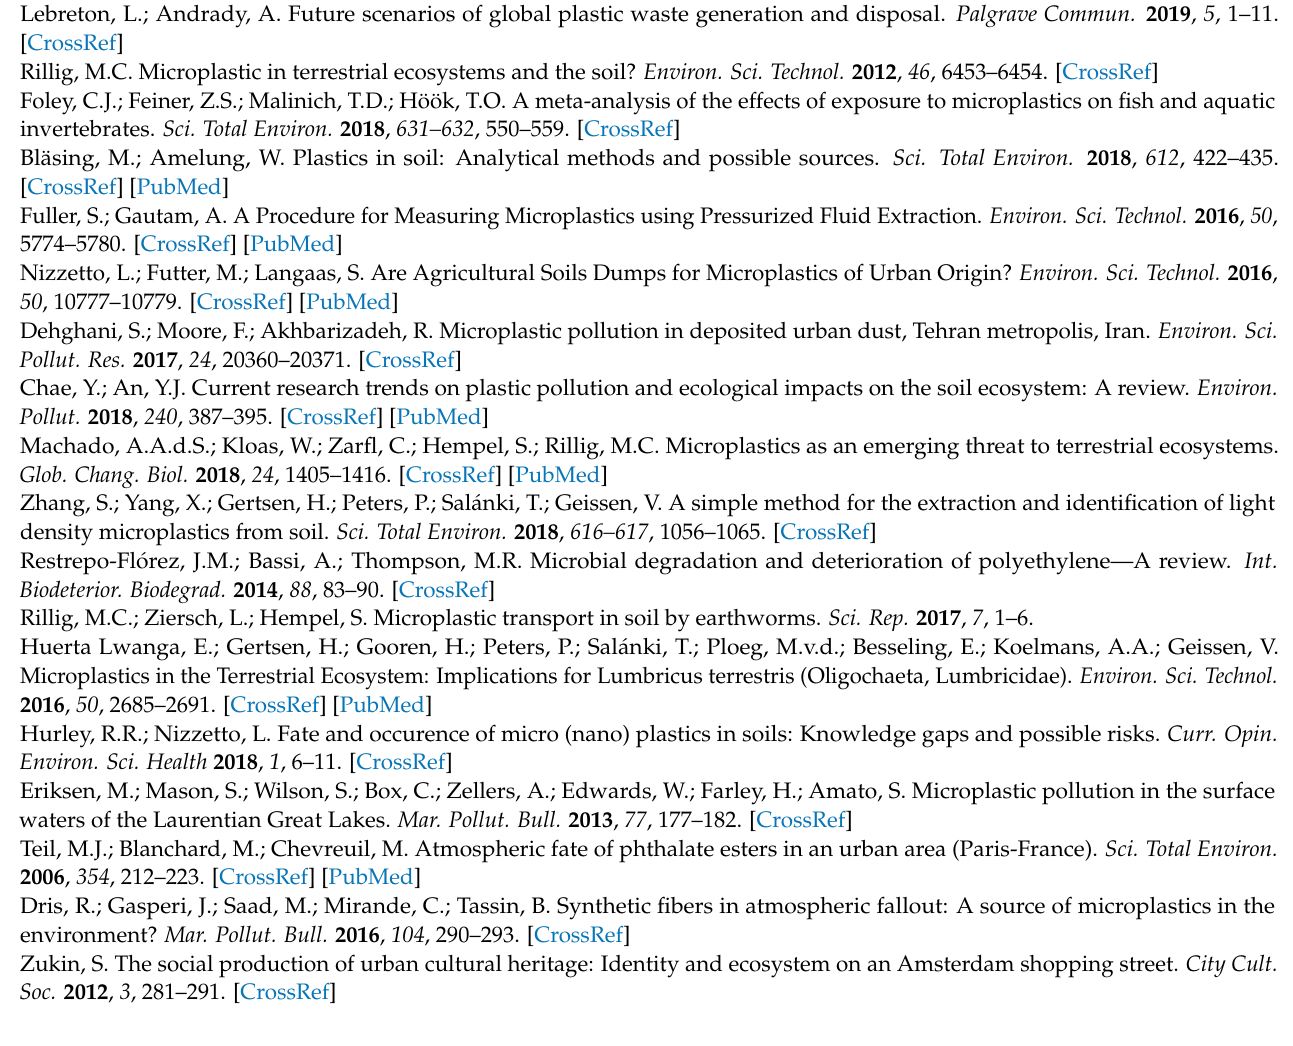
Netherlands (before fitting). Figure S7: Fitted variogram of moisture content in Amsterdam, The Netherlands. Figure S8: Variogram of pH in Amsterdam, The Netherlands (before fitting). Figure S9: Fitted variogram of pH in Amsterdam, The Netherlands. Table S1: Statistical data of microplastic particles per kg per city district in Amsterdam. No significant differences between city districts were observed after a Kruskal-Wallis test. Table S2: Microplastic particles [MPP/Kg] per park or recreational area in Amsterdam, The